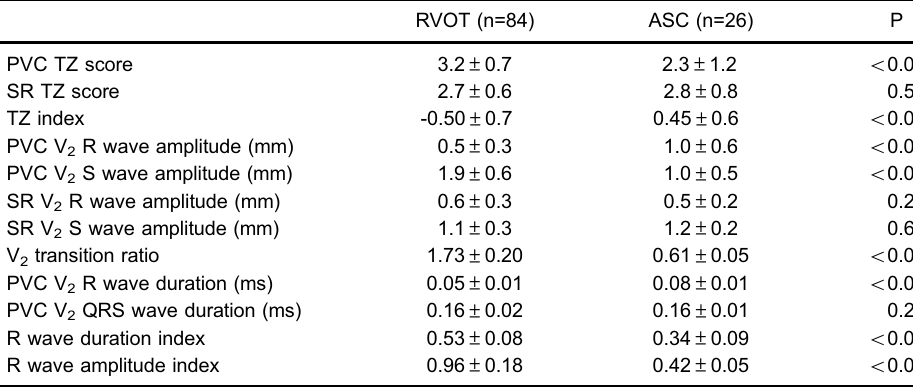
Table 2. Analysis of electrocardiograms.